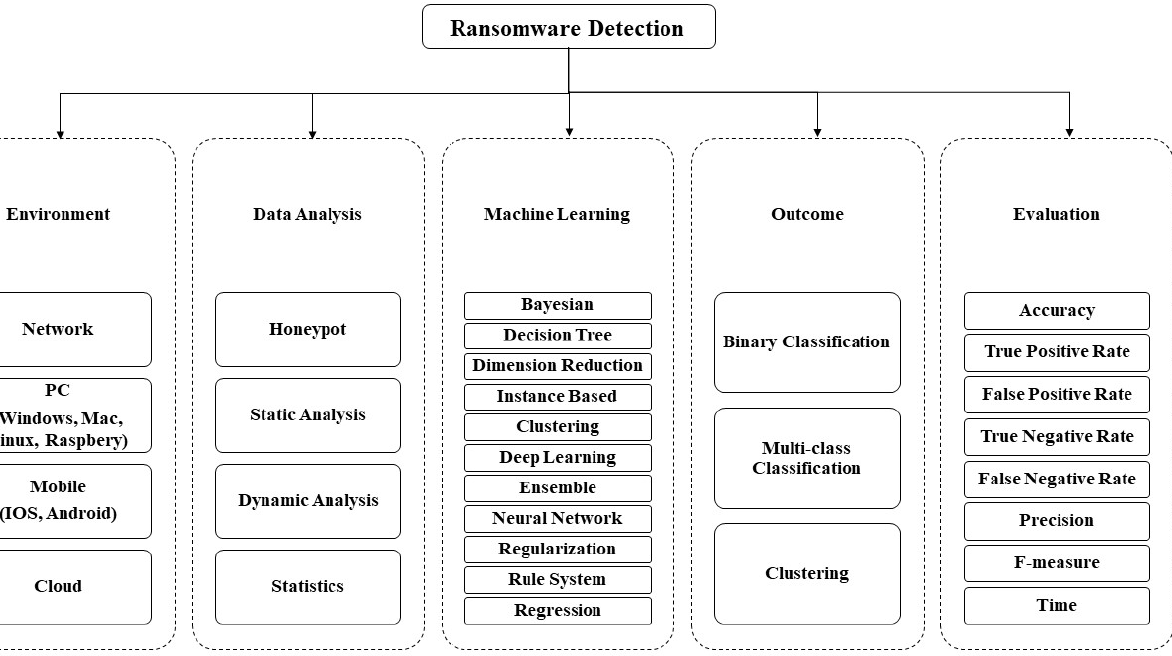
Figure 8. Ransomware detection ecosystem.